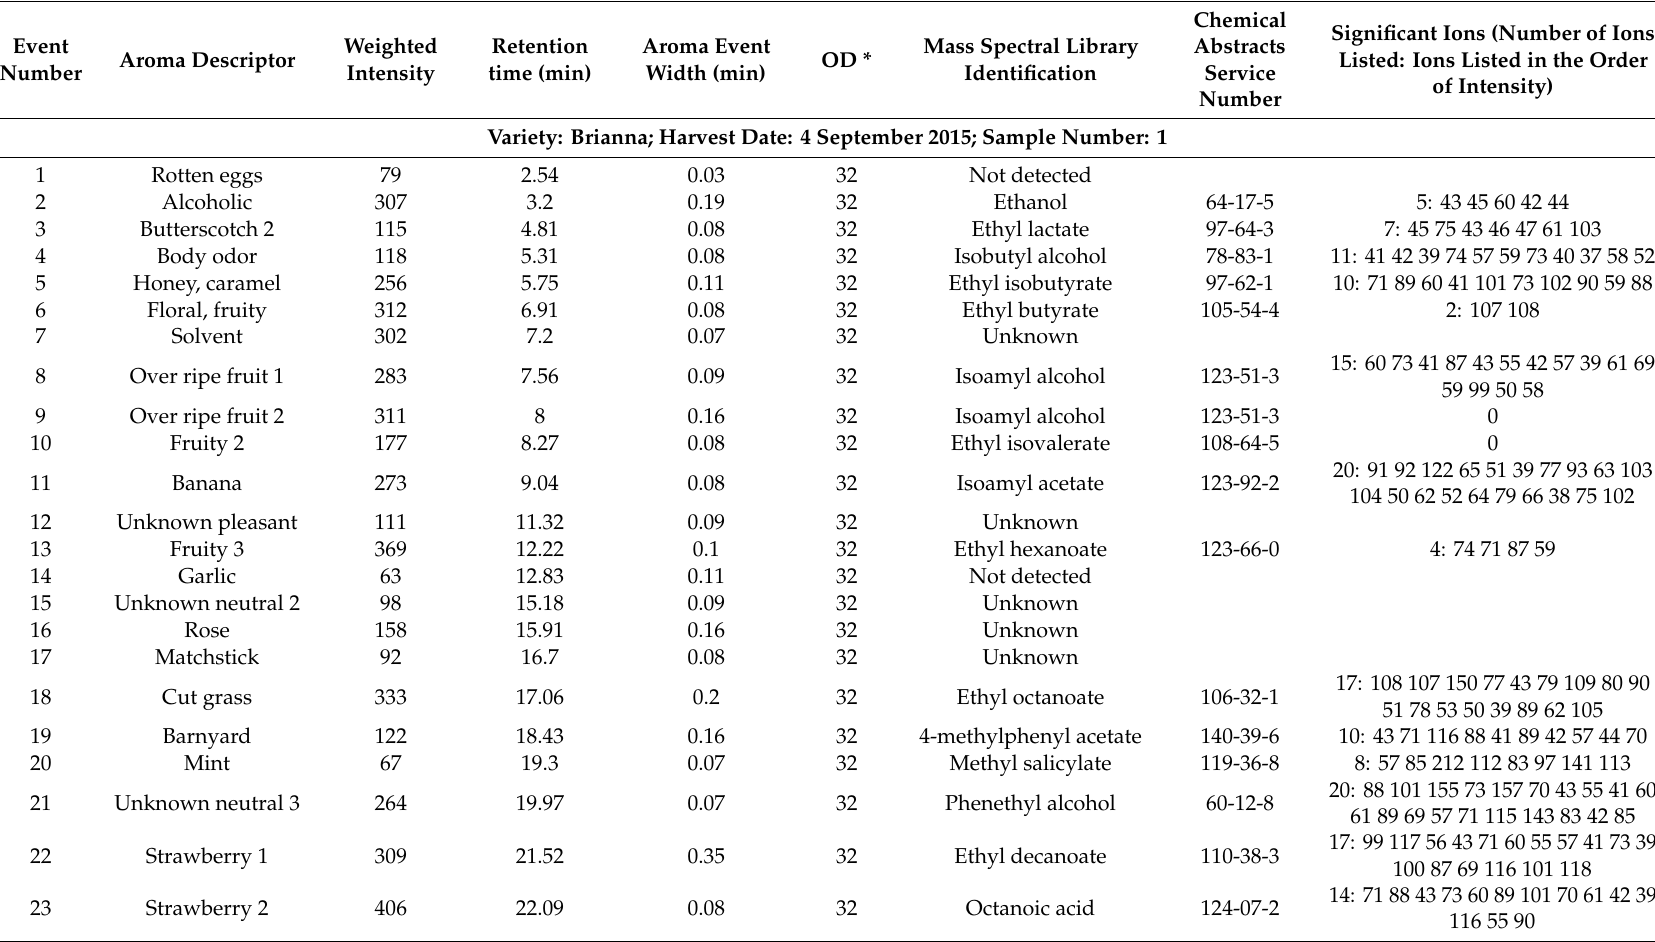
Table A1. Summary of identified aromas and associated compounds in the headspace of wines made from Brianna and Frontenac gris cold-hardy grapes. Percent match to NIST 11 mass spectral library was equal or greater than